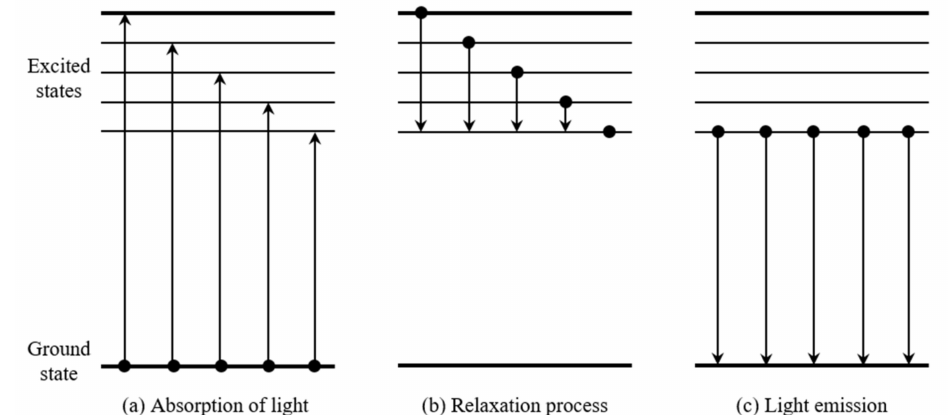
Figure 11. Excitation, relaxation, and emission processes of electronic transitions in transformer oil.